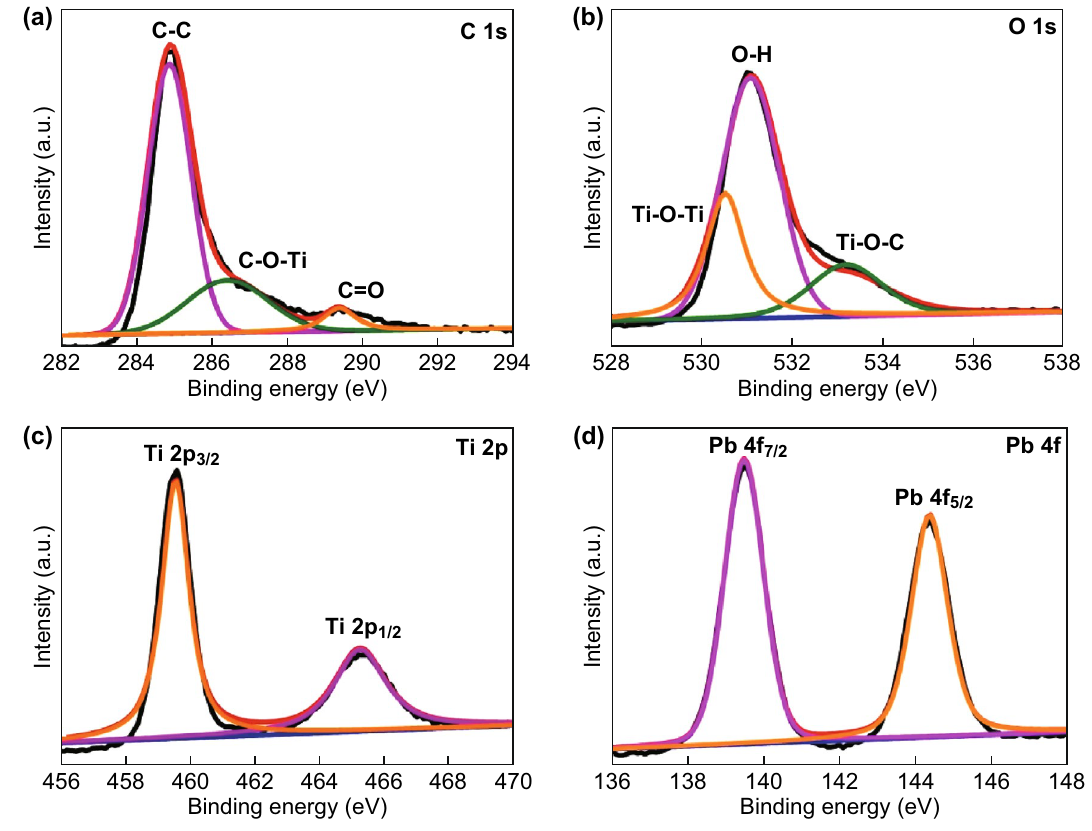
Fig. 2 High-resolution XPS spectra of a C 1 s, b O 1 s, c Ti 2p, and d Pb